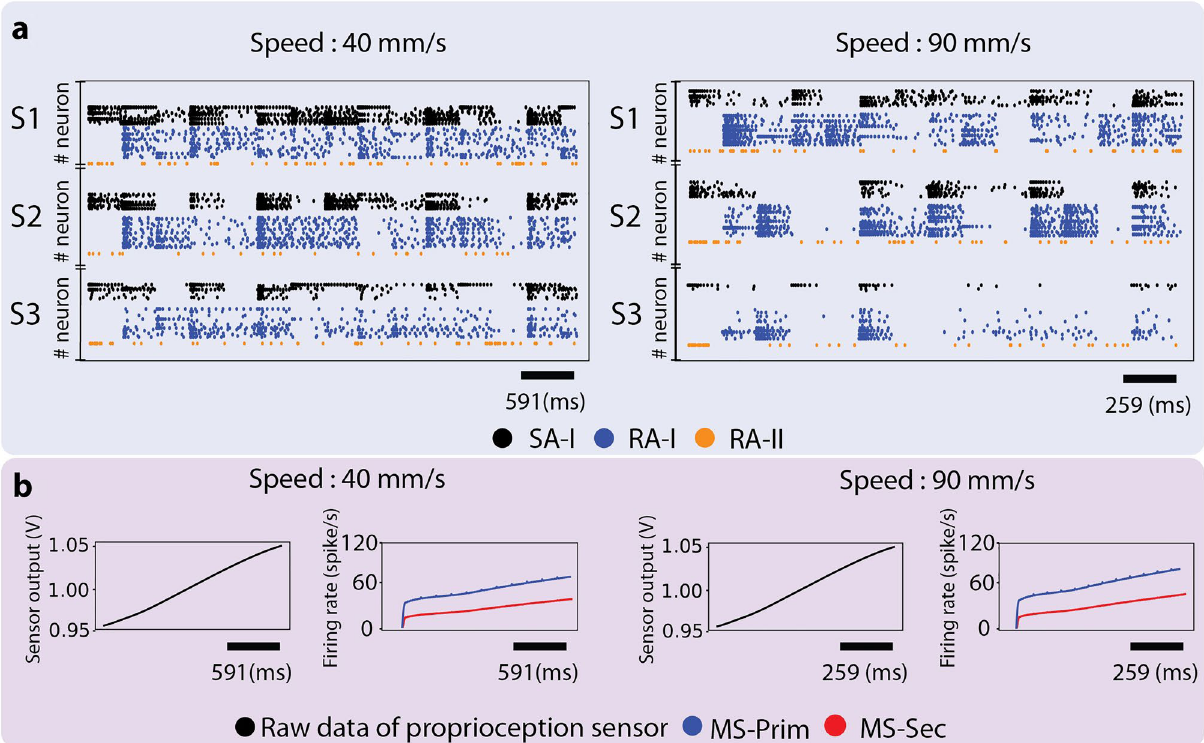
Figure 4. The responses of 12 SA-I, 24 RA-I, and 1 RA-II afferent in conjunction with muscle spindles afferents (MS-Prim and MS-Sec) for two scanning speeds (40 and 90 mm/s) and 3 surfaces (S1, S2, and S3). ( a ) The raster plot of the skin’s mechanoreceptors (spike train) for SA-I (Black), RA-I (Blue), and RA-II (Orange) for different surfaces. ( b ) The mapped length of the proprioception sensor and spike rate of muscle spindle afferents (MS-Prim (Blue) and MS-Sec (Red)) are shown (firing rates during the manipulation process),